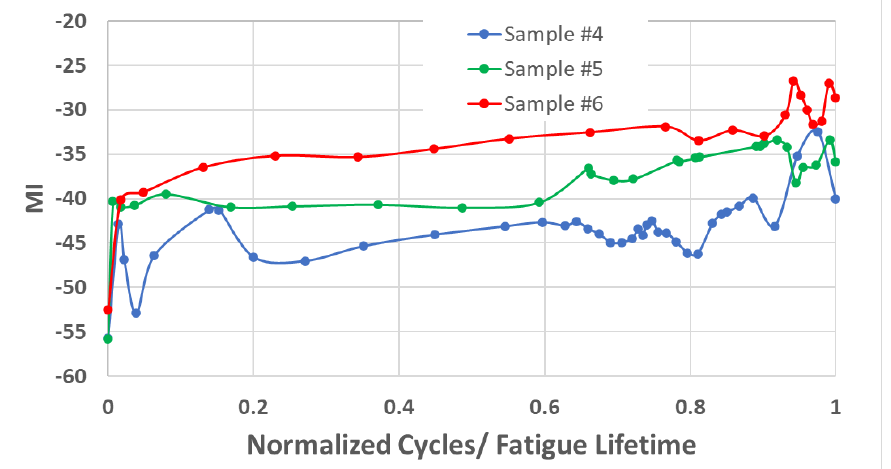
Figure 8. Three specimens failed after being examined by the MI versus the number of cycles ratio for average frequencies.